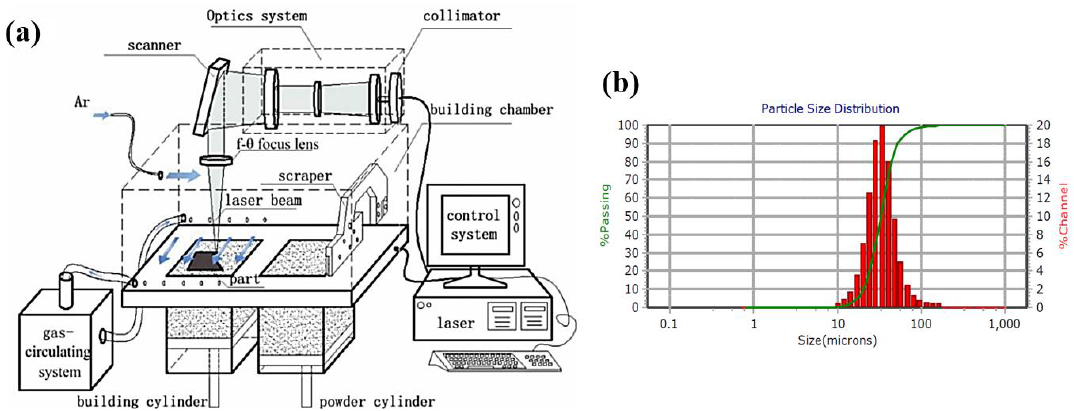
Figure 1. ( a ) Principle of selective laser melting (SLM) manufacturing equipment; ( b ) particle size distribution (PSD). Table 1. Powder composition of 316L (mass fraction, wt %).